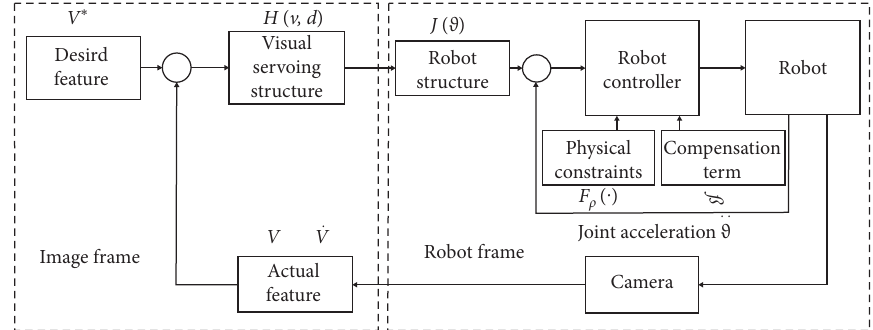
Figure 1: Control flowchart of the visual servoing scheme